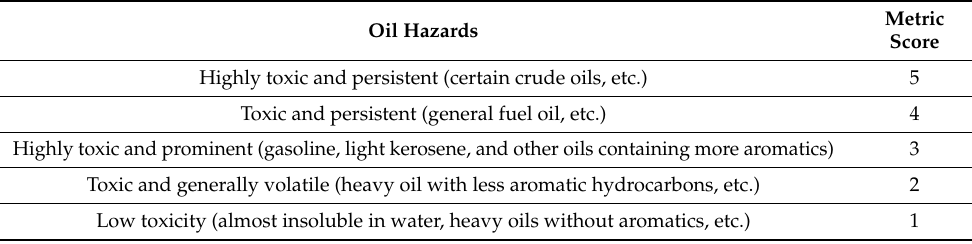
Table 3. Oil hazard index score.